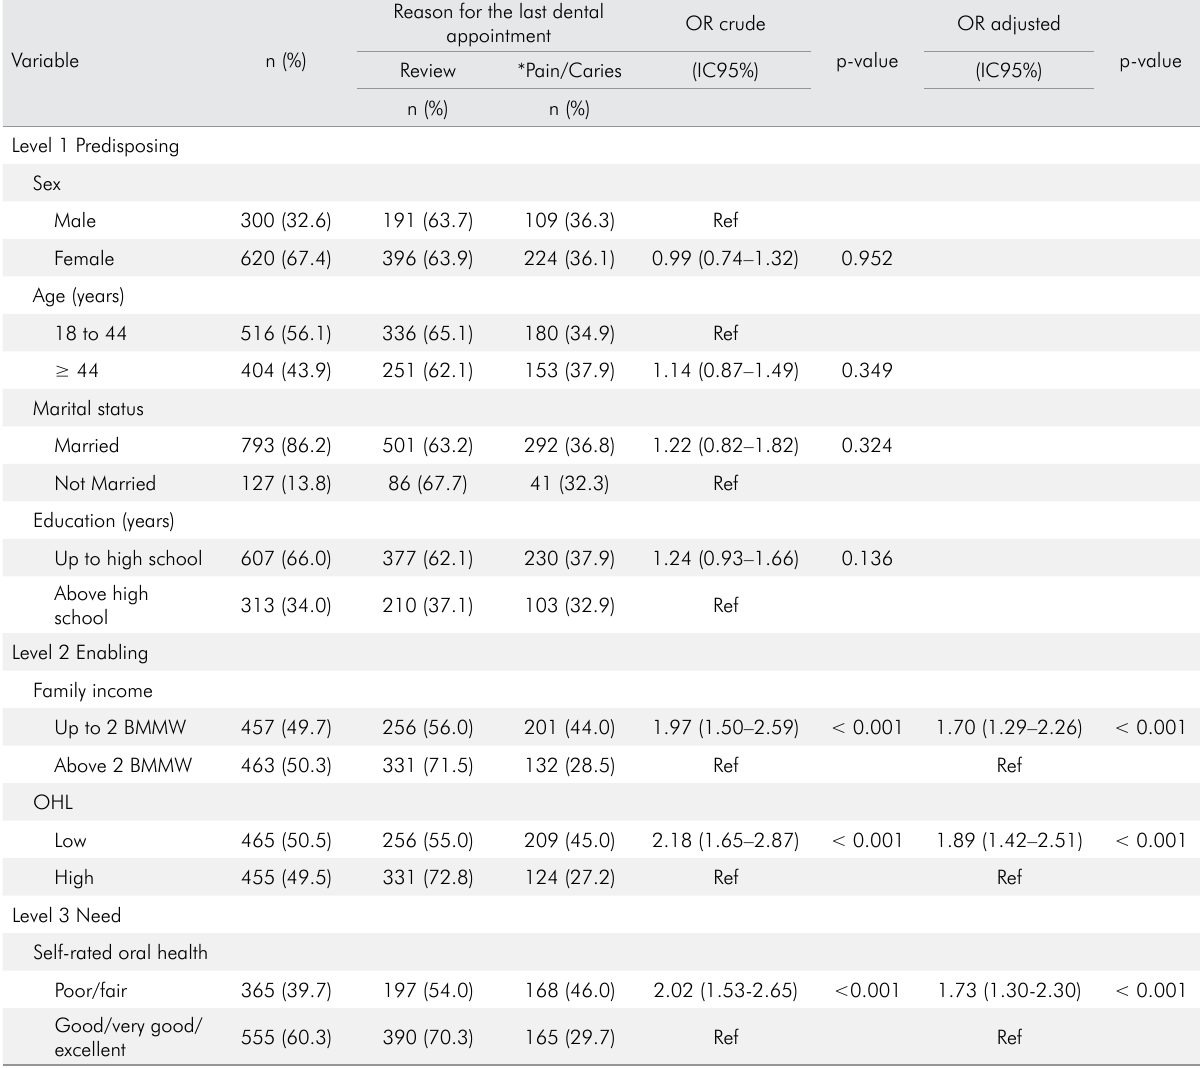
Table 2. Analysis (crude and adjusted) of the associations between the reason for the last dental appointment and independent